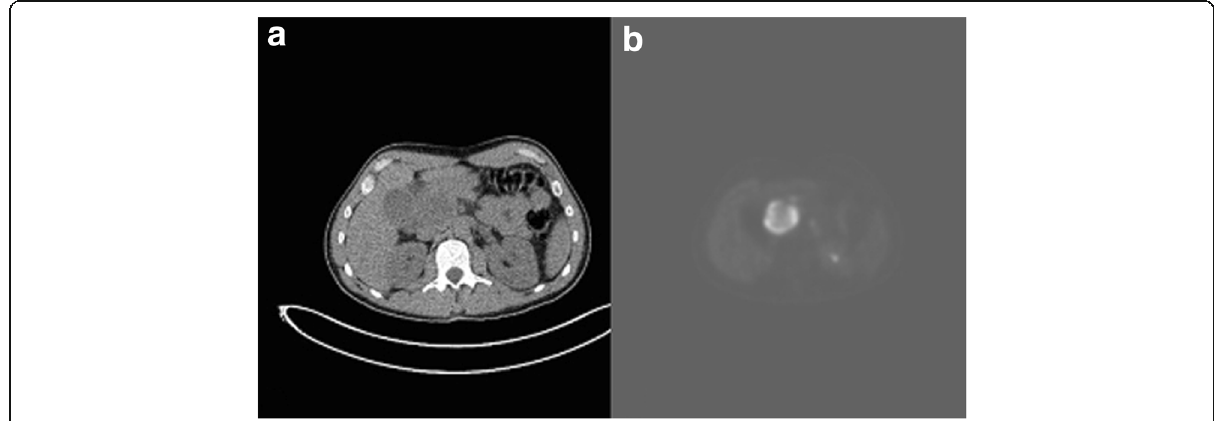
Fig. 1 a Abdominal CT showing a large periportal nodal mass and b Abdominal PET-CT showing avid tracer